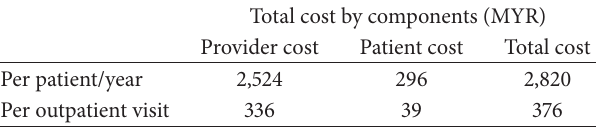
Table 1: Average treatment cost for periodontitis.